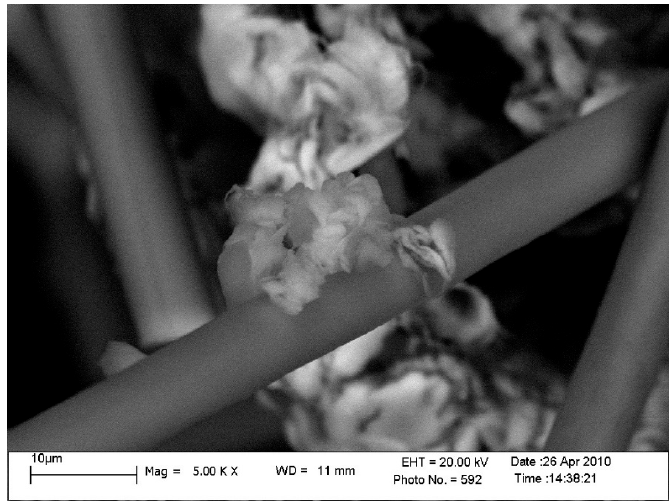
Figure 5. A layer with an increased content of PTFE on the surface of CF. Scale bar: 10 µm